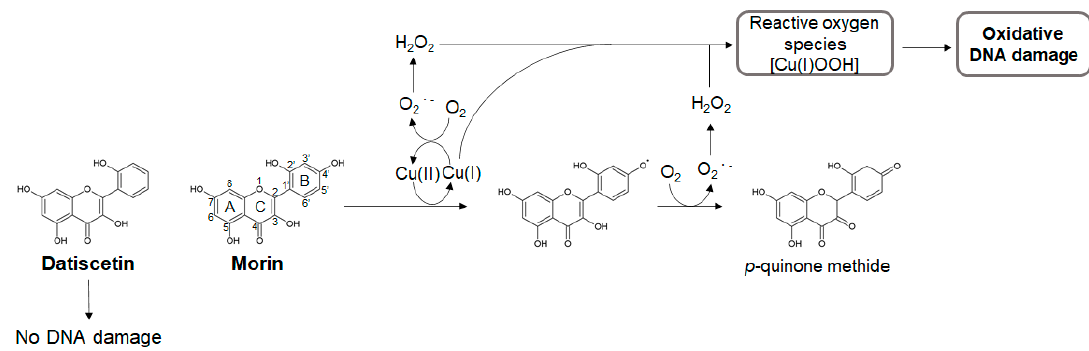
Figure 3. Possible mechanism of oxidative DNA damage induced by morin in the presence of Cu(II). The 4 ′ -hydroxyl group of the B-ring of morin is responsible for the generation of Cu(I)-hydroperoxide (Cu(I)OOH) and the resultant oxidative DNA damage. Datiscetin, an analog of morin, without the 4 ′ -hydroxyl group, does not damage DNA.